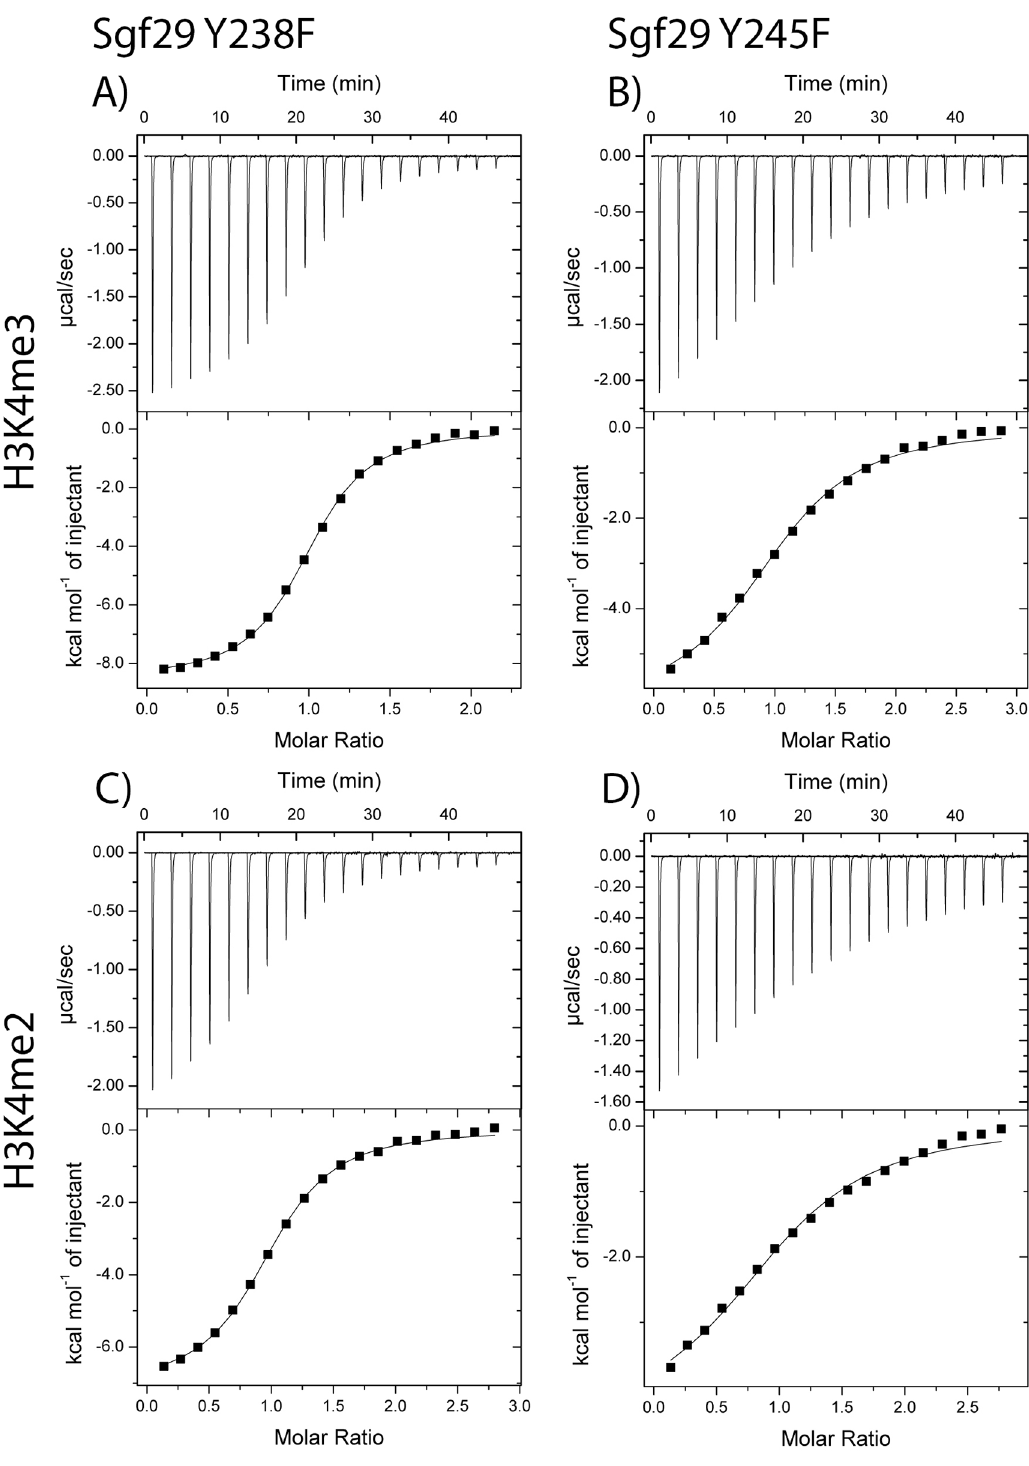
Fig 5. Representative ITC experiments displaying binding of H3K4me3 and H3K4me2 to Y238F and Y245F Sgf29 variants. A) H3K4me3-Y238F, B) H3K4me3-Y245F, C) H3K4me2-Y238F and D) H3K4me2-Y245F.